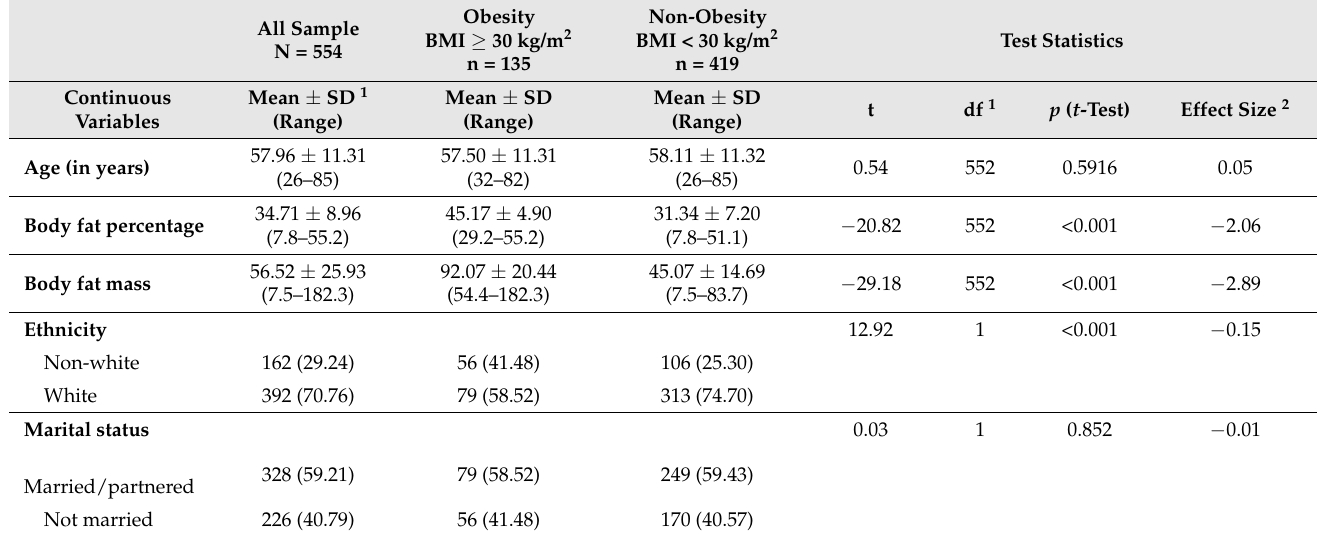
Table 1. Demographic characteristics of participants ( N =